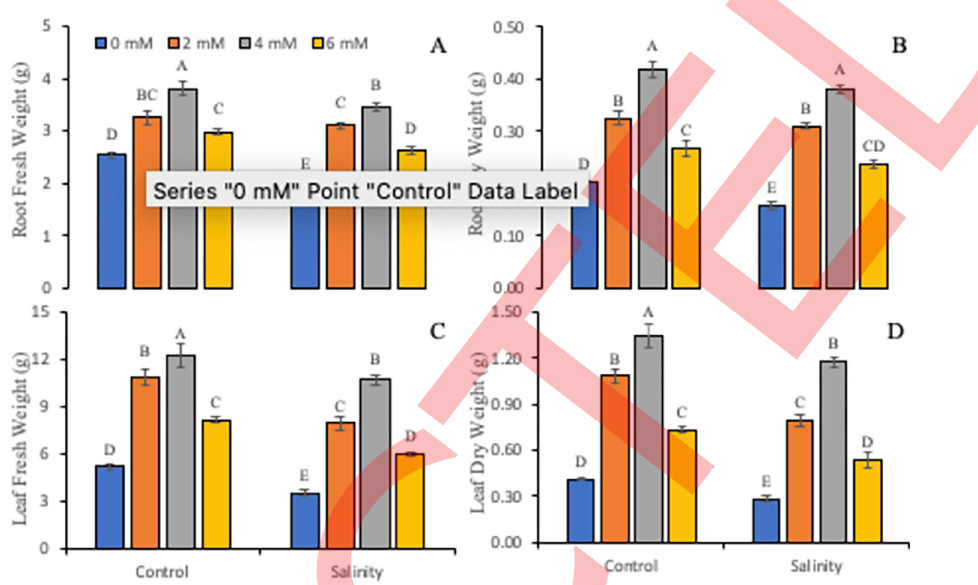
Fig 2. Fresh and dry biomass of roots and leaves attributes A) root fresh weight; B) root dry weight; C) leaf fresh weight and D) leaf dry weight of spinach at the harvesting stage in response to silicon (0, 2, 4, 6 mM) and salinity (150 mM NaCl) applications. For each parameter, mean data ( ± SD, n = 3) with different letters indicate a significant difference ( P < 0.05).